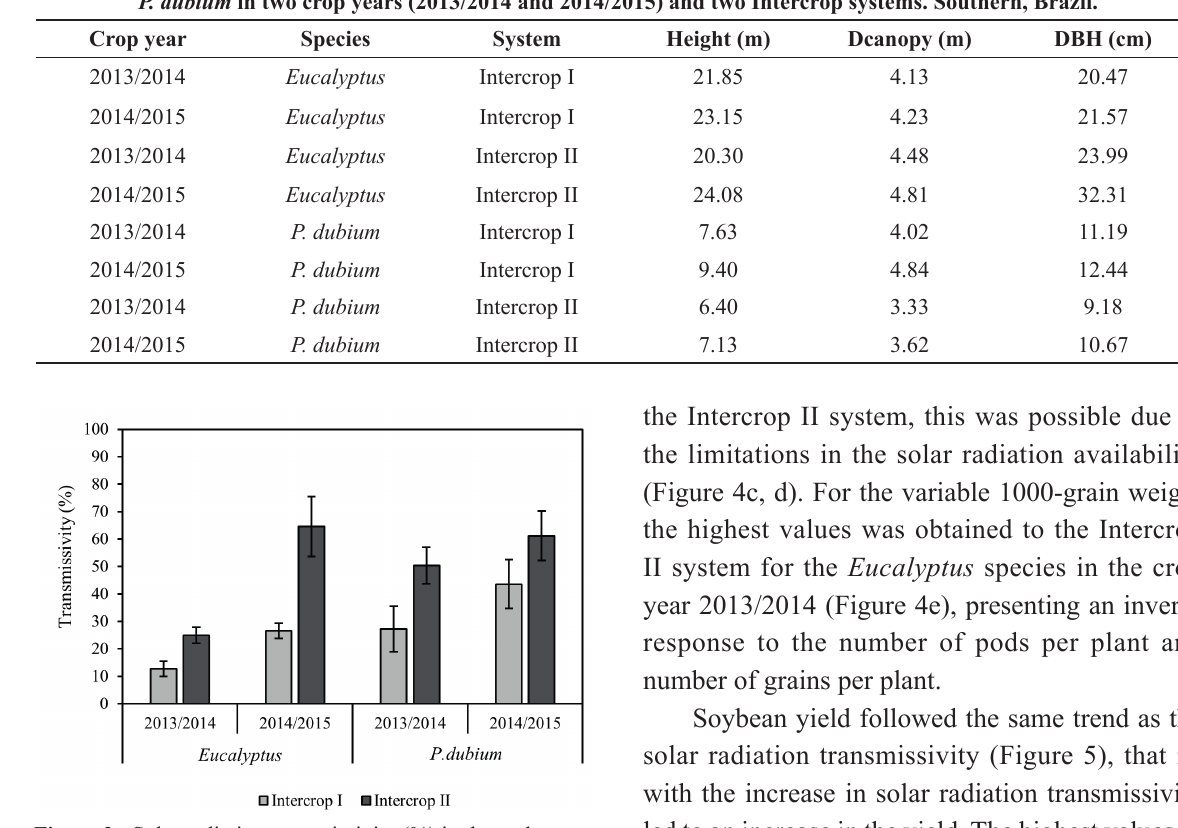
Figure 3 - Solar radiation transmissivity (%) in the understory of an agroforestry system with two forest species Eucalyptus and P. dubium in two Intercrop systems (Intercrop I and Intercrop II) and two crop years (2013/2014 and 2014/2015). Each bars represent average values ± SE. Southern,